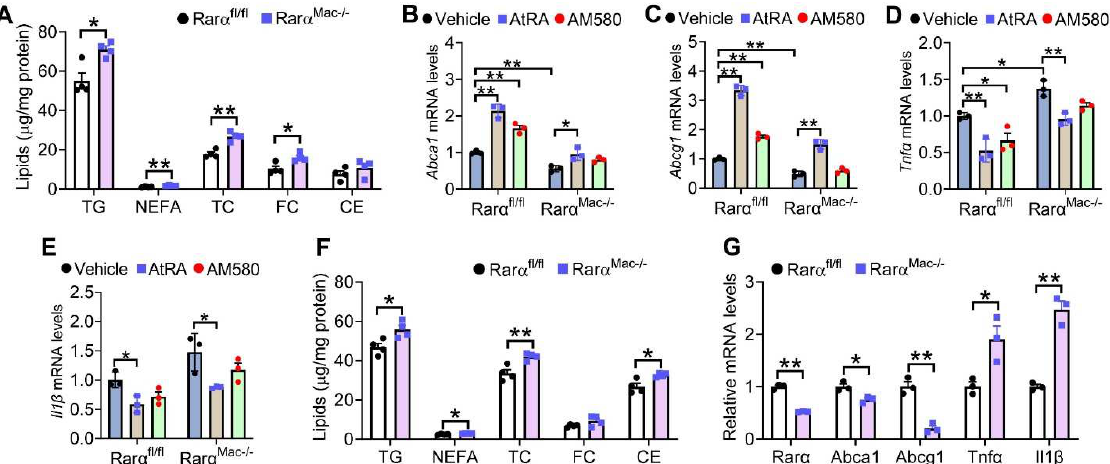
Figure 2. Loss of RARα induces lipid accumulation and inflammation in macrophages. ( A – E ) Peri- toneal macrophages were isolated from Rarα fl/fl mice or Rarα Mac-/- mice, and then treated with Ac-LDL (25 mg/mL) for 48 h. The cells were also treated with vehicle, AtRA (2 µM), or AM580 (2 µM). Intra- cellular lipids ( A ) and mRNA levels of Abca1 ( B ), Abcg1 ( C ), Tnfα ( D ) or Il1β ( E ) were determined ( n = 4). ( F , G ) Rarα fl/fl mice and Rarα Mac-/- mice were fed a Western diet for 16 weeks. Intracellular lipid ( F ) and mRNA levels ( G ) were determined ( n = 3). In ( A , F – G ), unpaired two-tailed Students’ t-test was used for statistical analysis. In B-E, ordinary two-way ANOVA with Tukey’s multiple compar- isons test was used for statistical analysis. All the data are expressed as mean ± SEM. * p < 0.05, ** p < 0.01.